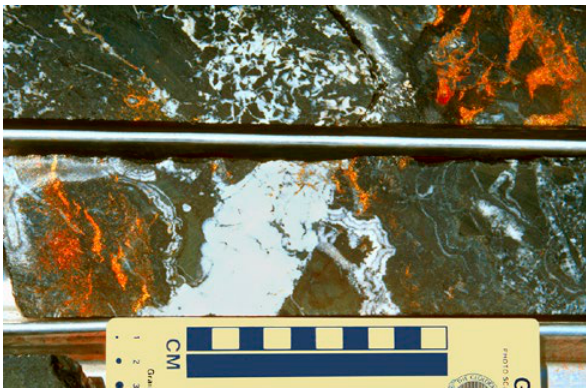
Figure 39. Colloform banding in the quartz magnetite and sulphide lode cored at New Cobar Mine, has been further disrupted at the gel precursor stage. Vein quartz ‘wells’ across the colloform bands and one of the magnetite layers has been brecciated so that highly angular and delicate fragments of now very heavy magnetite are suspended in a matrix of more fluid and rheopectic silica gel. The rheopectic re-setting of the precursor polymeric silica has “frozen” the delicate magnetite precursor fragments in